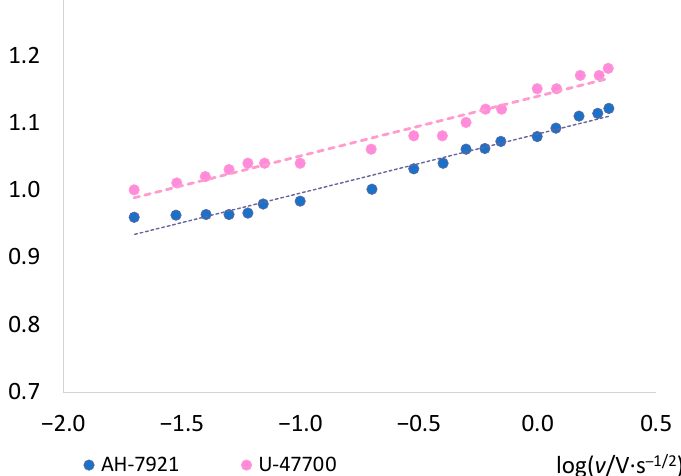
Figure 3. E p vs. log v graph for the first voltammetric peak of U-47700 (pink curve) and for the first voltammetric peak of AH-7921 (blue curve). Equations are reported in Table 3.